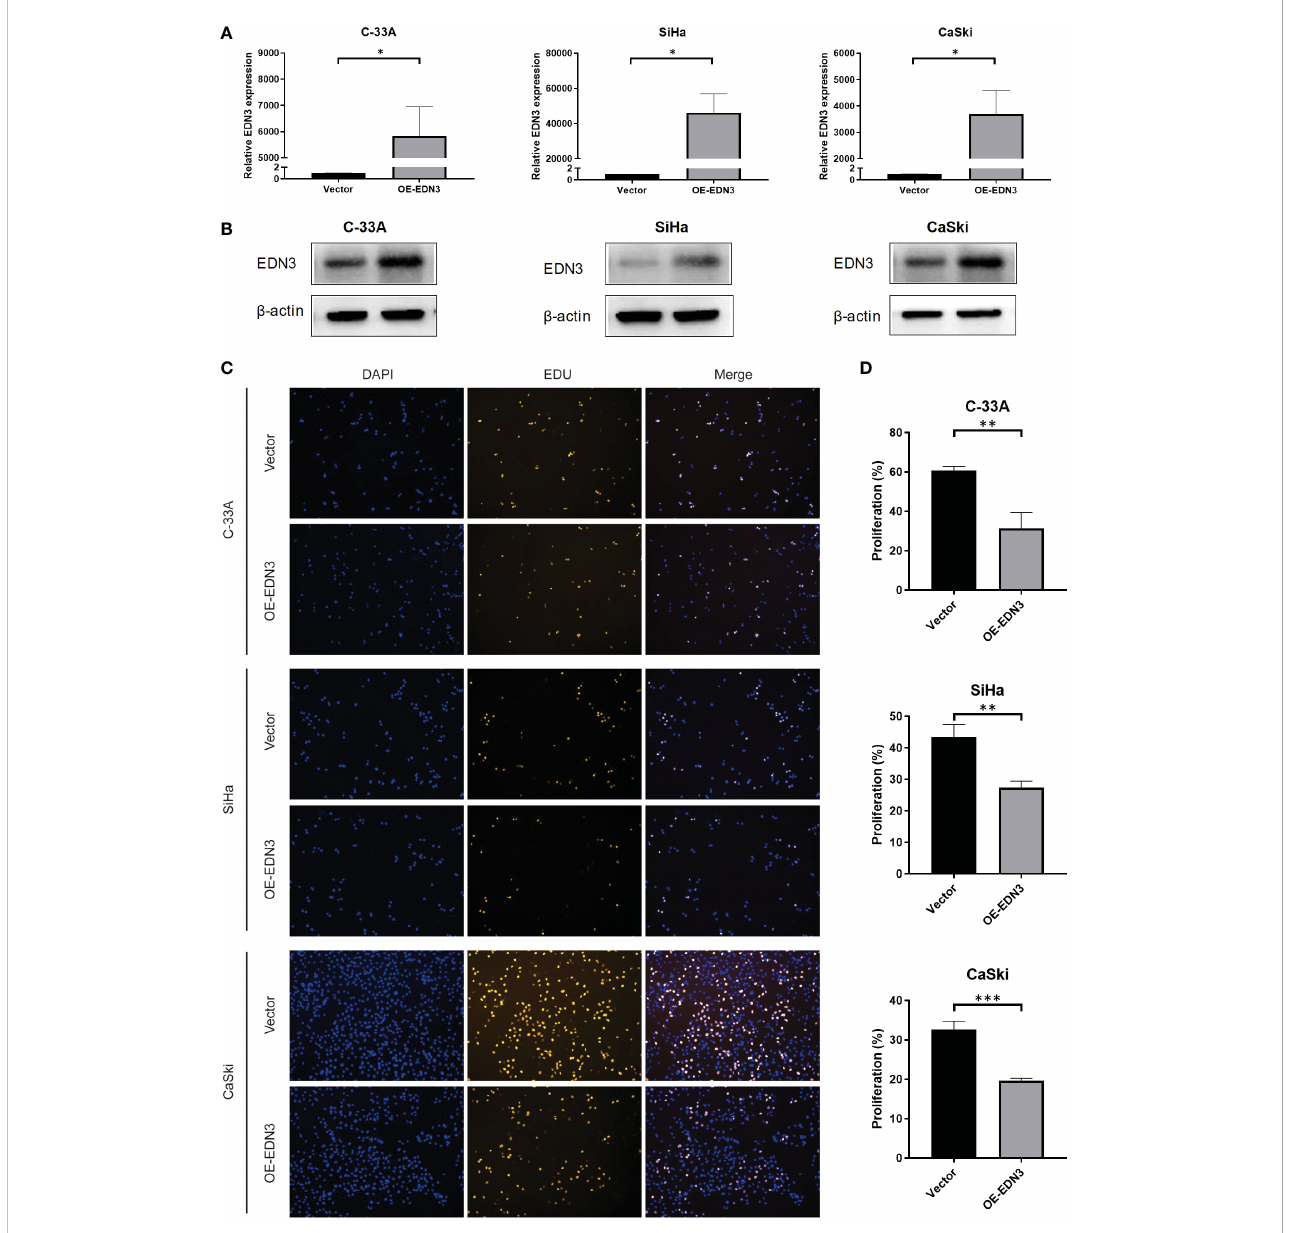
FIGURE 3 Overexpression of EDN3 inhibited the proliferation of C-33A, SiHa and CaSki cells. (A) The mRNA expression of EDN3 in C-33A, SiHa and CaSki cells transfected with OE- EDN3 and vector. (B) The protein expression of EDN3 in C-33A, SiHa and CaSki cells transfected with OE- EDN3 and vector. (C) Overexpression of EDN3 inhibited the proliferation of C-33A, SiHa and CaSki cells by EdU assay. (D) The proliferation percent after transfection of OE- EDN3 and vector were measured. Values are mean ± SD, N = 3; *P<0.05; **P<0.01;